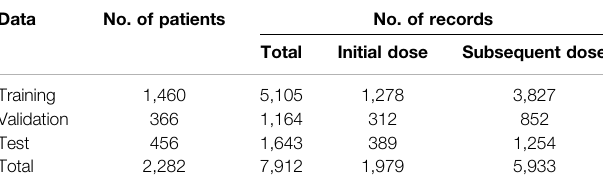
TABLE 1 | Distribution of patients and records in different data sets. Data No. of